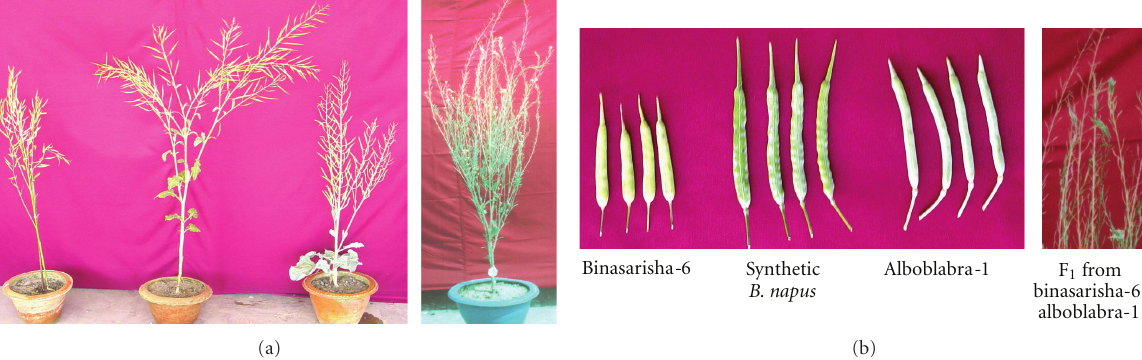
Figure 2: (a) Plants of Binasarisha-6, synthetic B. napus , Alboglabra-1, and F 1 , and (b) siliquae of Binasarisha-6, synthetic B. napus , and Alboglabra-1, and rachis without siliqua in F 1